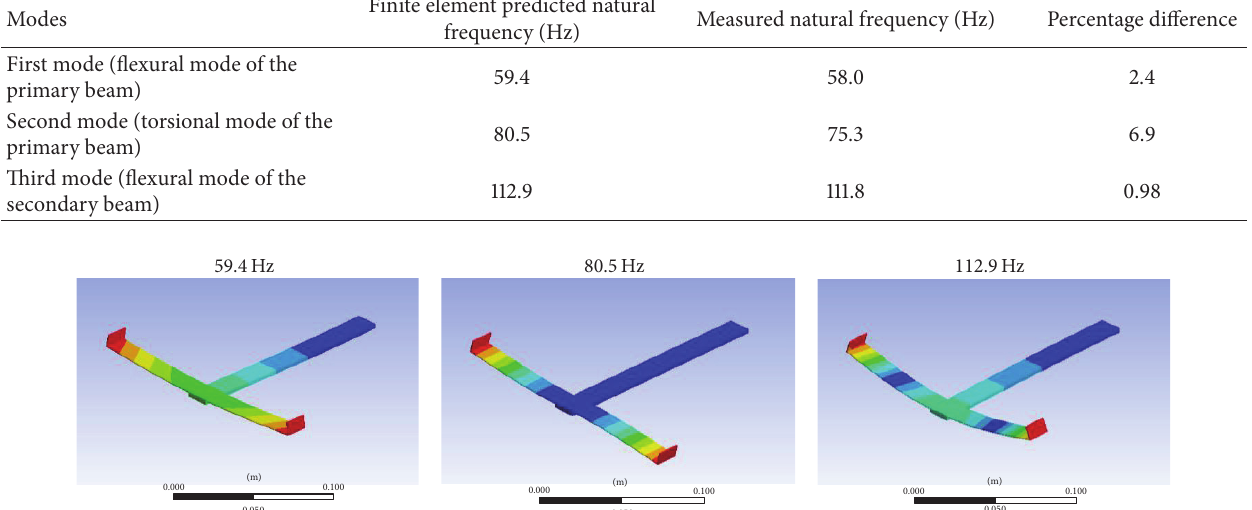
Figure 13: Predicted mode shapes of the T-beam system with thin secondary beam.